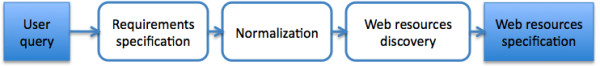
Overview of the proposed approach. The approach is divided on three phases: requirements specification, normalization and web resource discovery.